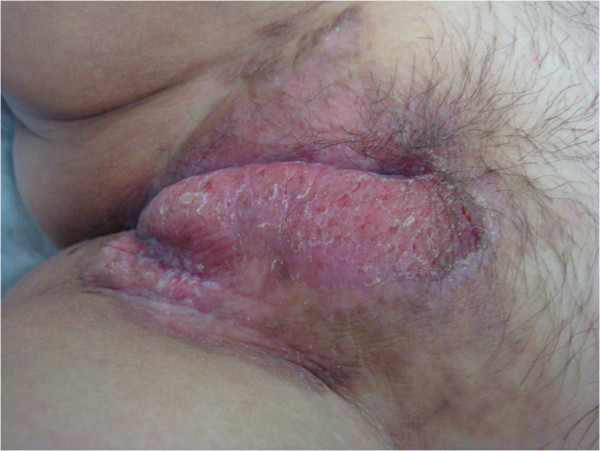
Picture of vulva.